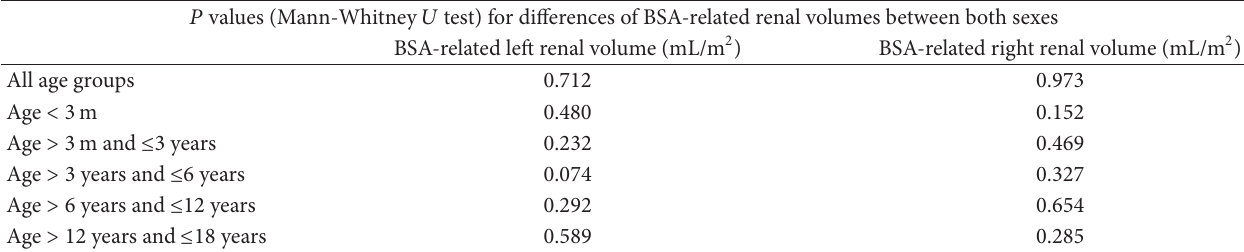
T 2: �o signi�cant differences of BSA-related renal volumes between both sexes